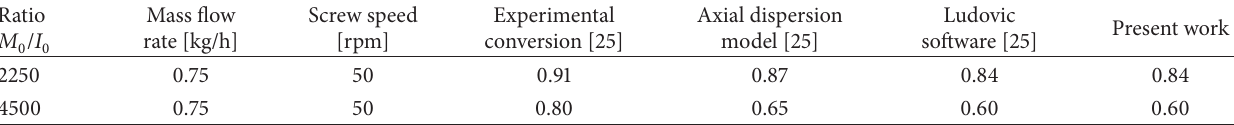
Table 2: Experimental and predicted conversion at the extruder exit using SnOct 2 /TPP.